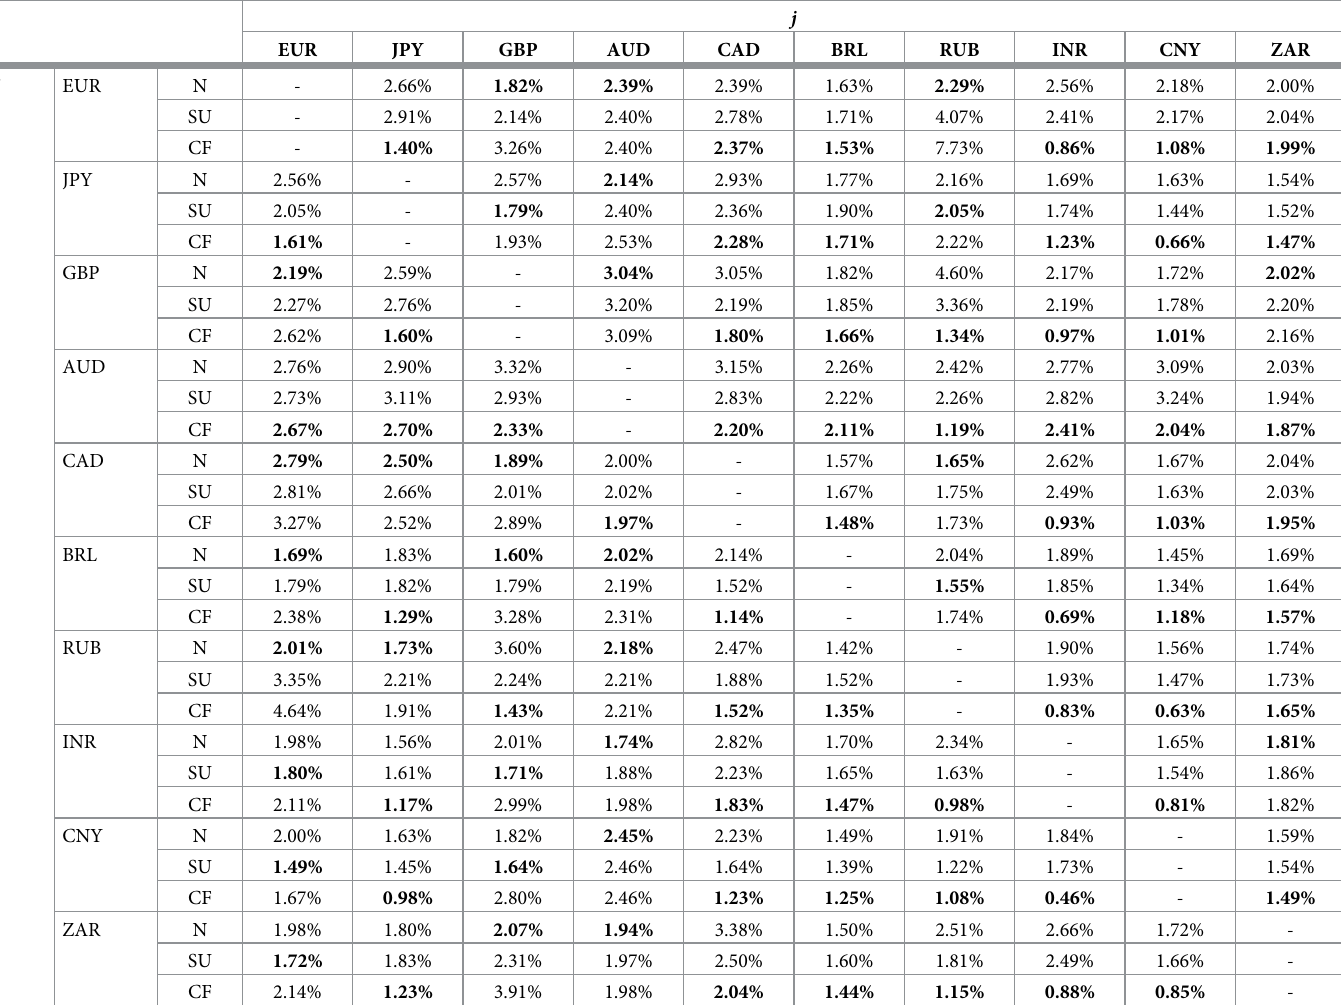
of the forecasted MCoVaR 5 % j j i ; n ij